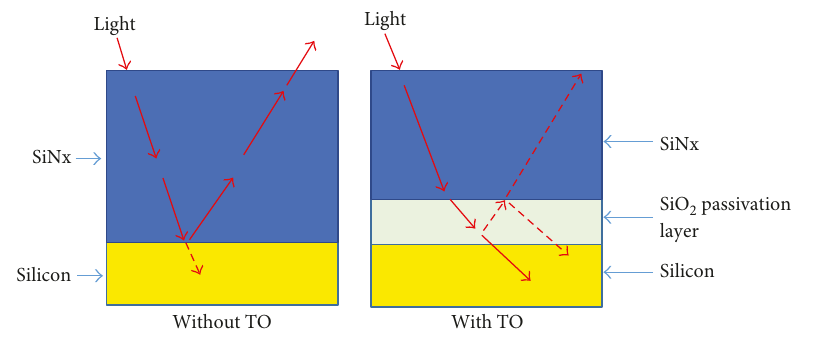
Figure 6: Lower average re fl ectance mechanism.